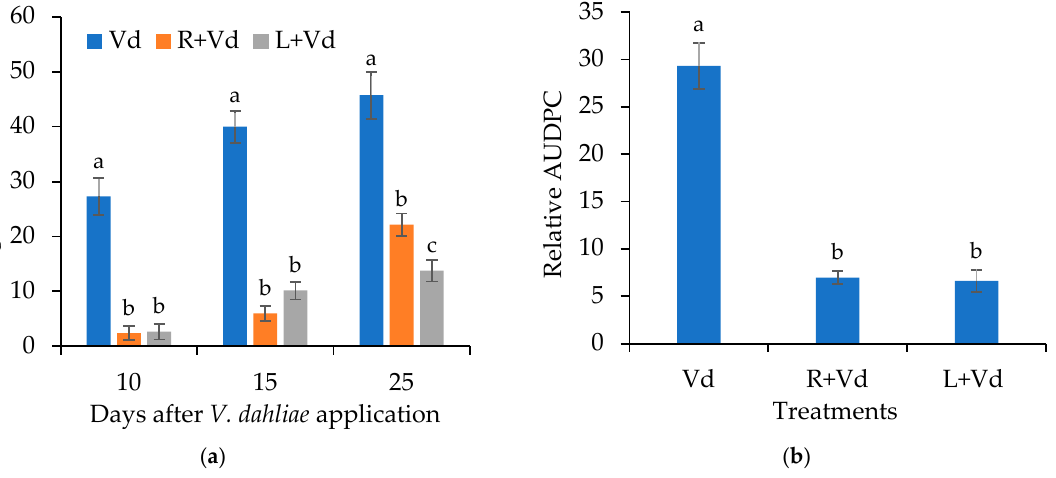
Figure 1. Disease severity ( a ) and relative AUDPC ( b ) caused by artificial inoculation of V. dahliae (Vd), on Arabidopsis thaliana leaf injected (L + Vd) or root drenched (R + Vd) with autoclaved spores of V. dahliae or mock inoculated (positive control, Vd). Columns represent means of three replications per treatment ( n = 30 plants, ± SE). Different letters denote statistically significant differences between treatments ( p < 0.05) according to LSD test. For disease severity, statistics were performed at each time point.